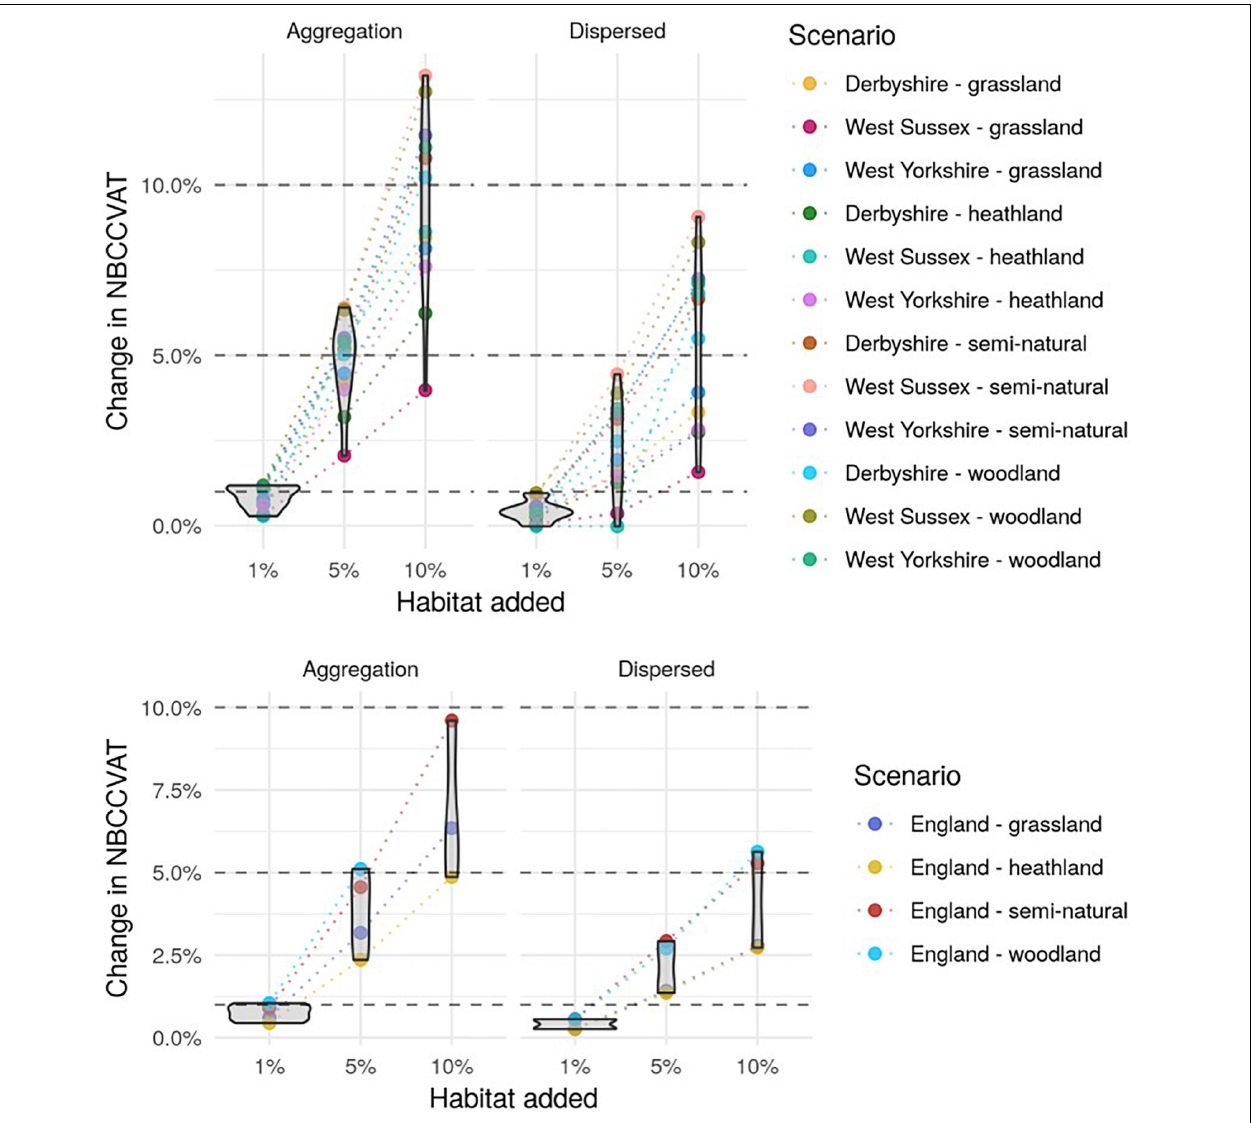
FIGURE 4 | Proportional increase in the National Biodiversity Climate Change Vulnerability Assessment Tool (NBCCVAT) metric for each of the simulated landscapes at the county scale (top) and England scale (bottom). The points are the proportional change in the metric from the baseline for each scenario, with dashed lines connecting the three levels of habitat addition. Violin plots show the distribution of the metric’s proportional change across habitats (for England) and habitat-counties combinations for each of the habitat addition amounts and spatial arrangements. The width of the violin represents the approximate frequency of data points in each region. Dashed horizontal lines indicate a 1, 5, and 10% change in the